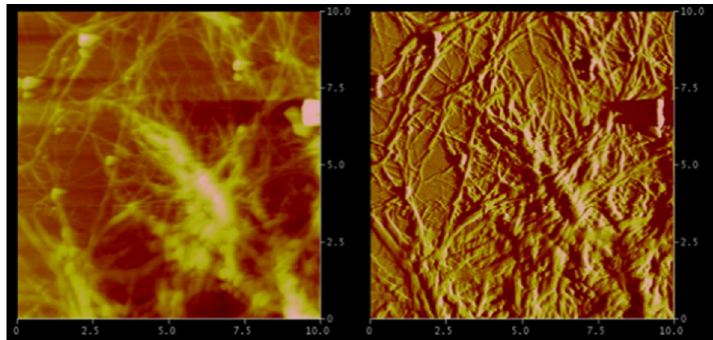
Figure 41. AFM images of a 10 mg/mL hydrogel from 62 (left, height image; right, phase image) [87].